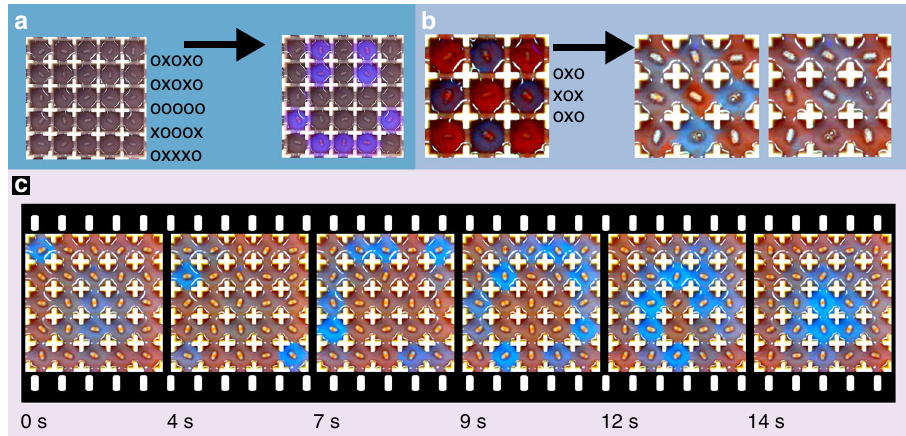
Fig. 2 Controlling the oscillating cells. In this fi gure, some frames are accompanied by a matrix of x ’ s and o ’ s. This matrix indicates if in that given frame a motor was enabled (marked with a x) or disabled (marked with a o). a With a v-shaped opening between cells, the oscillations generated at a given cell do not propagate to neighbouring cells. This way, the BZ reaction within each cell can be individually controlled, and the user can de fi ne which cells oscillate and which cells do not oscillate. b To increase the transfer of liquid between cells, the gap between cells was fully opened. This way we achieve the objective of enabling a cell which was disabled just by enabling its surrounding cells. c Once the cells are weakly connected, they will generate coherent patterns. (Note: the oscillations in the top-left image have been contrast-enhanced, Supplementary Movie 3 shows the unedited oscillations. See Supplementary Note 1 for more details.).